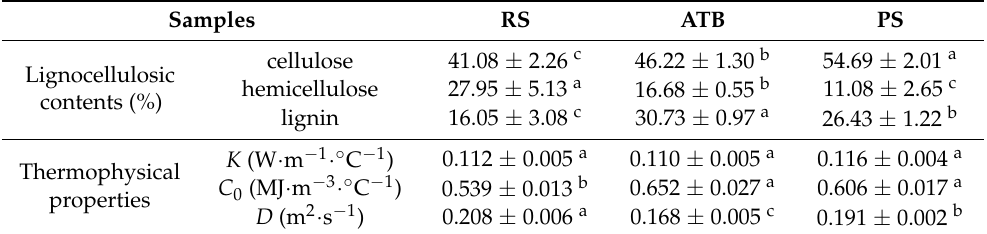
Table 3. Lignocellulosic contents and thermophysical properties of